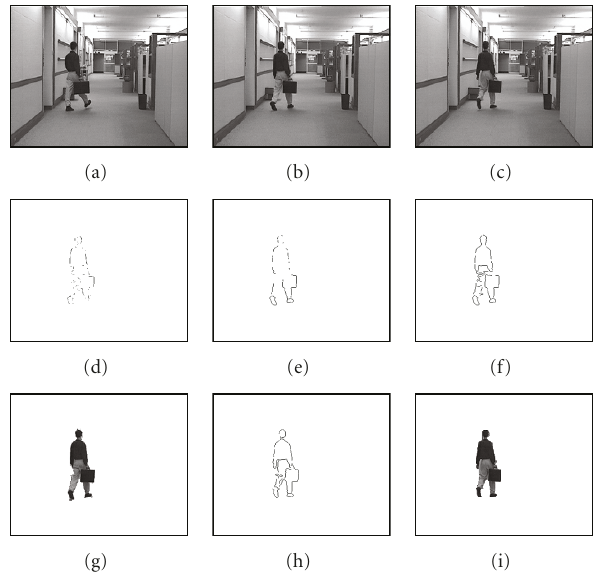
Figure 8: Detection and segmentation of moving object in “Hall Monitor” sequence. (a) I 46 ; (b) I 47 ; (c) I 48 ; (d) detected moving edges of I 47 by DC ; (e) detected moving edges of I 47 by SD ; (f) detected moving edges of I 47 by the proposed method; (g) segmented moving edges by of I 47 the proposed method; (h) moving edges of I 48 by the proposed method; (i) segmented moving object of I 48 by the proposed method.